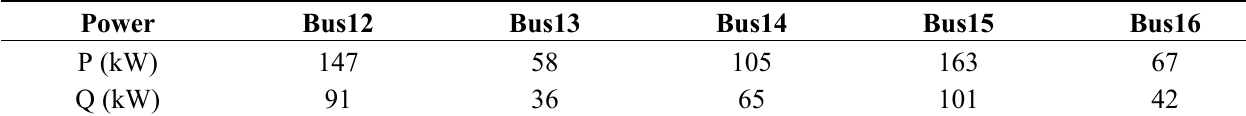
Table 2. The power values of five nonlinear loads.